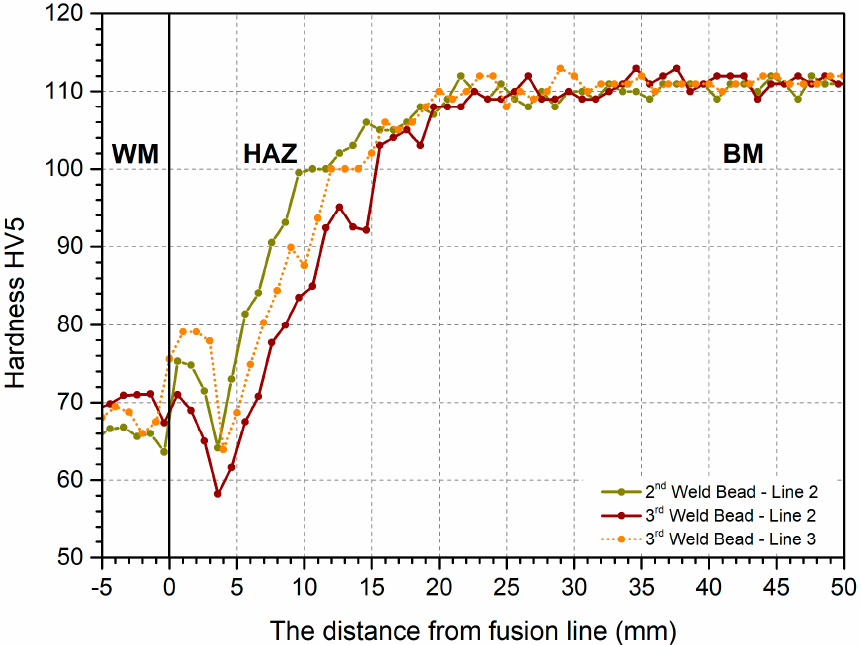
Figure 10. Measured hardness values in the weld metal, HAZ and base material for weld 1 (with preheating at 75 °C) in the zone of line 2 after application of the second and third weld beads.